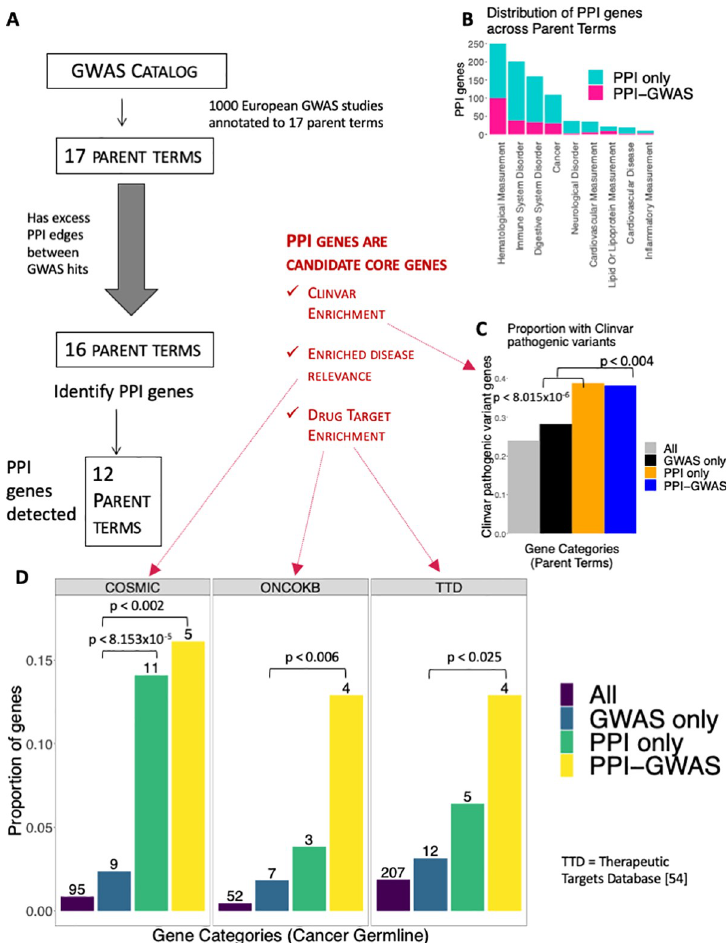
Fig 4. PPI genes in Parent Terms. (A) Each study in the GWAS catalog is annotated with parent terms. In order to find PPI genes amongst parent terms, we merged GWAS hits from different GWAS studies with the same parent term. We first looked for evidence of excess PPI among parent term GWAS hits. Out of 17 parent terms, we found excess PPI among GWAS hits within 16 parent terms and detected PPI genes in 12 parent terms. (B) The proportion of PPI genes in each parent term that is PPI only vs. PPI-GWAS. The ‘Lipid and Lipoprotein Measurement’ parent term had the largest proportion of PPI-GWAS. (We excluded the parent terms ‘Biological Process’, ‘Other Measurement’ and ‘Other Disease’ due to vagueness). (C) Proportion of Clinvar pathogenic variant containing genes in All 11,049 nodes, GWAS only, PPI only and PPI-GWAS. We found enrichment in PPI only compared to GWAS only (p < 8.015x10 -6 , Fisher’s Exact Test) and in PPI-GWAS compared to GWAS only (p < 0.004, Fisher’s Exact Test). (D) Overlap of cancer parent term PPI genes with COSMIC, ONCOKB or Therapeutic Targets Database genes respectively. The numbers on top of each bar correspond to the number of PPI genes that overlaps with the genes from that gene category. COSMIC: Cancer Parent Term PPI genes were compared to the COSMIC cancer gene census germline genes [52]. Compared to GWAS only, we found that PPI-GWAS (p < 0.002, Fisher’s Exact Test) and PPI-only (p < 8.153x10 -5 , Fisher’s Exact Test) were enriched for overlaps. ONCOKB: Cancer drug targets were obtained from Oncokb [53] and we found enrichment in PPI-GWAS (p < 0.006) compared to GWAS only. TTD: Cancer drug targets were obtained from the Therapeutic Targets Database [54] (Methods), and we found enrichment in PPI-GWAS (p < 0.025, Fisher’s Exact Test) compared to GWAS